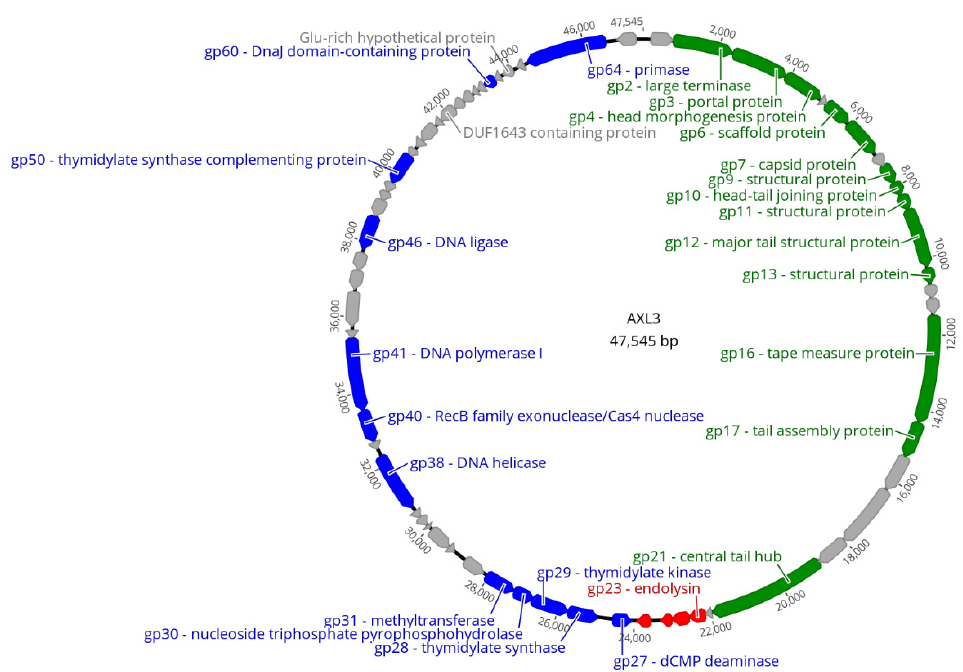
Figure 3. Circularized genomic map of AXL3. Scale (in bp) is shown on the outer periphery. Assigned putative functions for each of the 65 predicted open reading frames are as follows: lysis (red), DNA replication and repair (blue), virion morphogenesis (green), hypothetical (grey). No tRNA or lysogeny genes were identified. AXL3 has a GC content of 63.3%. Image created using Geneious Prime [36].